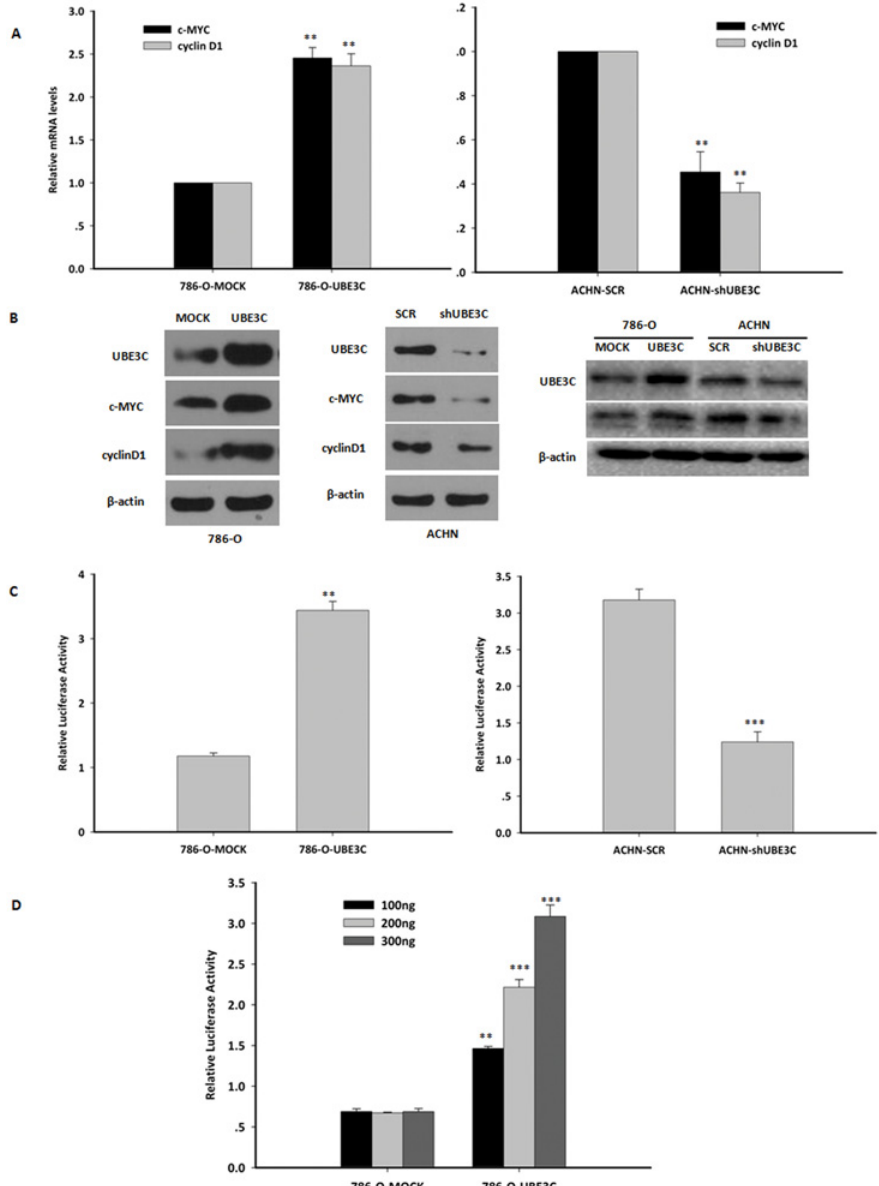
Figure 4. UBE3C activates Wnt/ β -catenin pathway. (A) Left, UBE3C overexpression in 786-O cells up- regulated c-MYC and cyclin D1 mRNA levels. Right, UBE3C knockdown in ACHN cells down-regulated c- MYC and cyclin D1 mRNA levels. Means (cid:1) SD from three independent experiments were presented as relative ratio to the control whose value was taken as 1.0. (B) Left, overexpression of UBE3C increased c- MYC and cyclin D1 protein levels in 786-O cells. Middle, knockdown of UBE3C decreased c-MYC and cyclin D1 protein levels in ACHN cells. Right, overexpression of UBE3C increased p-GSK3 β level in 786-O cells, meanwhile knockdown of UBE3C decreased p-GSK3 β level in ACHN cells. (C) Left, overexpression of UBE3C up-regulated the LEF reporter activity in 786-O cells. Right, UBE3C knockdown down-regulated the LEF reporter activity in ACHN cells. Means (cid:1) SD of normalized luciferase activity from three independent experiments were presented. (D) UBE3C activated the LEF reporter in dose-dependent manners. 786-O cells were co-transfected with the expression constructs of UBE3C and the LEF reporter. Significant differences were determined using Student ’ s t test, * P < 0.05, ** P < 0.01, *** P < 0.001.